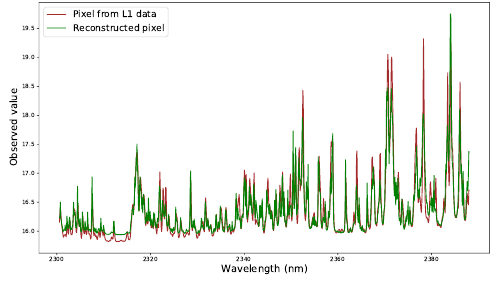
Figure 3. Comparison between the original pixel and the approximated